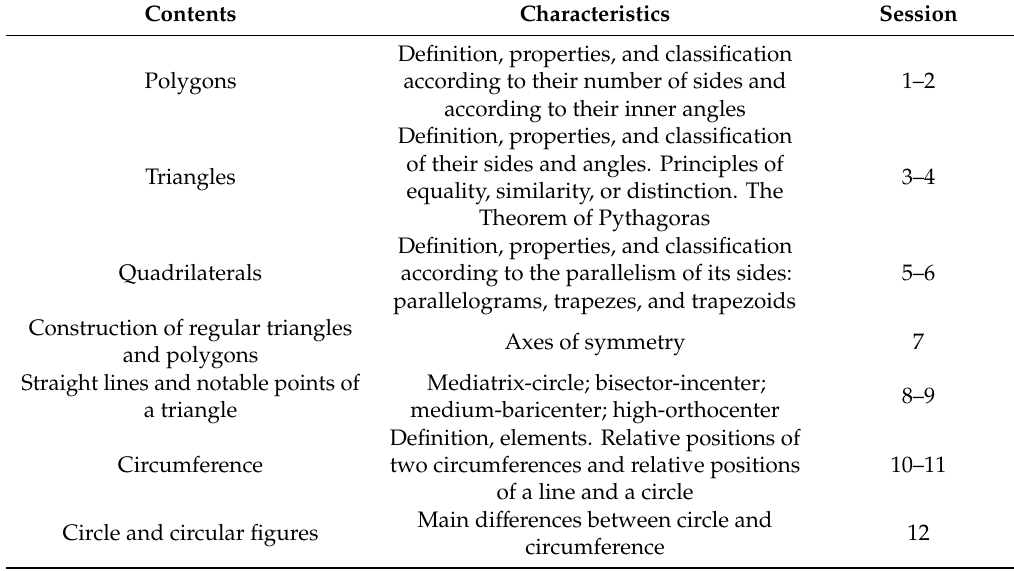
Table 2. Contents worked on during the